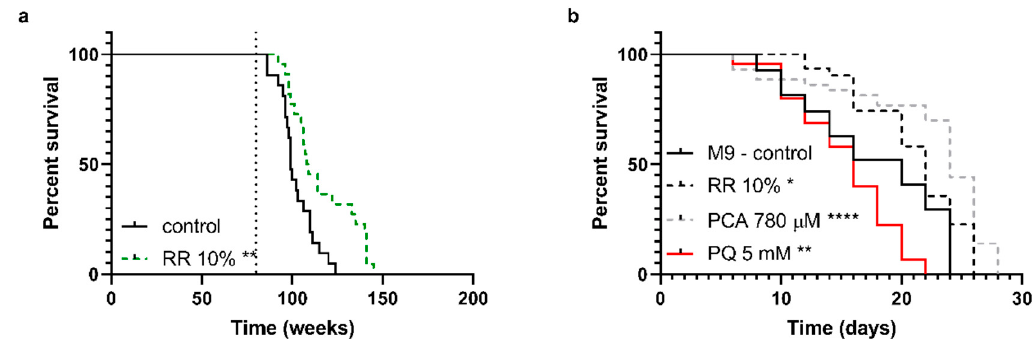
Figure 2. ( a ) Survival rates of NMRI mice with or without supplementation of RR via drinking water until time of death. Mice received a 10% supplementation of RR starting with the age of 20 months (indicated by the dotted line), leading to a significantly increased lifespan. ( b ) Survival of wild-type C. elegans N2 treated with RR 10%, PCA 780 µM, and paraquat 5 mM was determined under physiological conditions until day of death; n = 22 (a; NMRI), n = 48 (b; C57BL/6J), and n = 27–44 (c;